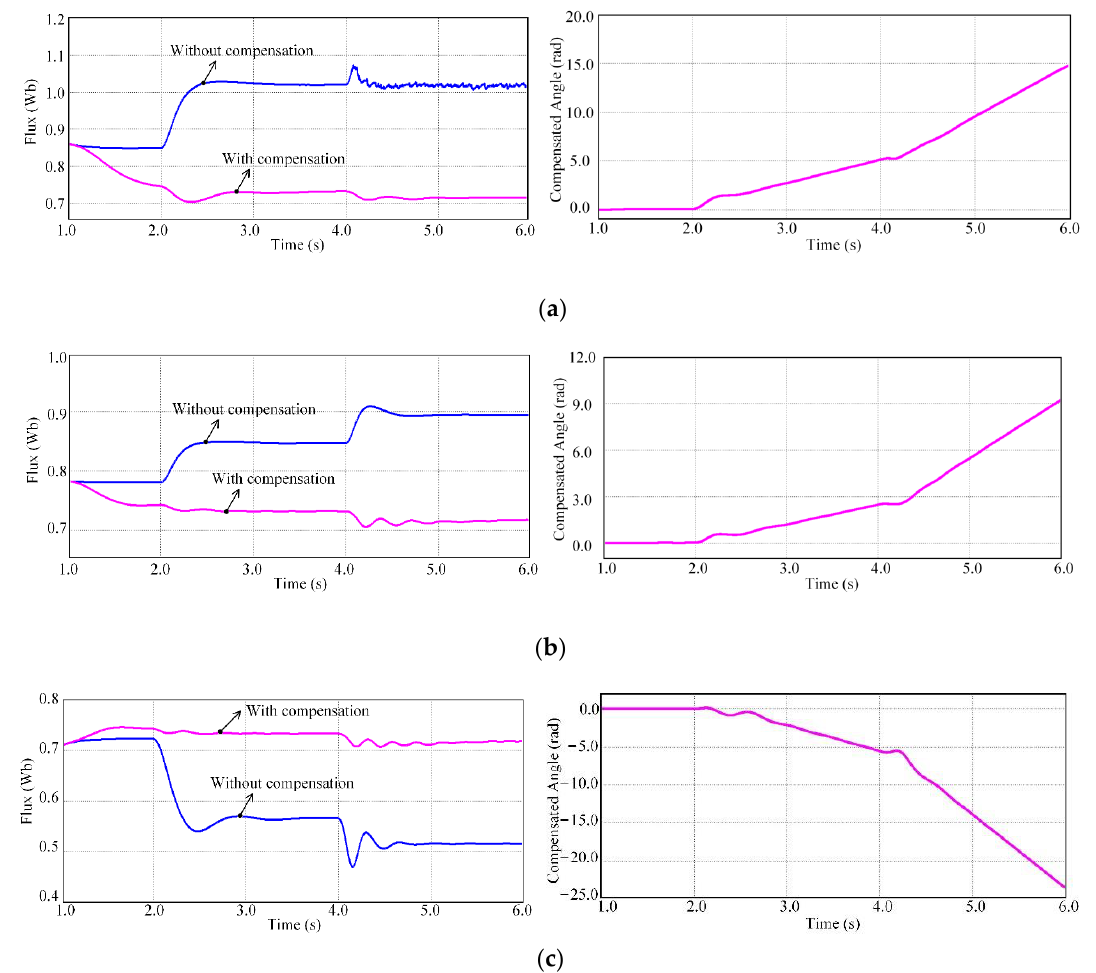
Figure 5. Flux and compensated angle at 1200 rpm with 30 Nm and 60 Nm step loads at 2.0 s and 4.0 s, respectively. ( a ) R ∗ r = 0.5 R r ; ( b ) R ∗ r = 0.8 R r ; ( c ) R ∗ r = 1.5 R r